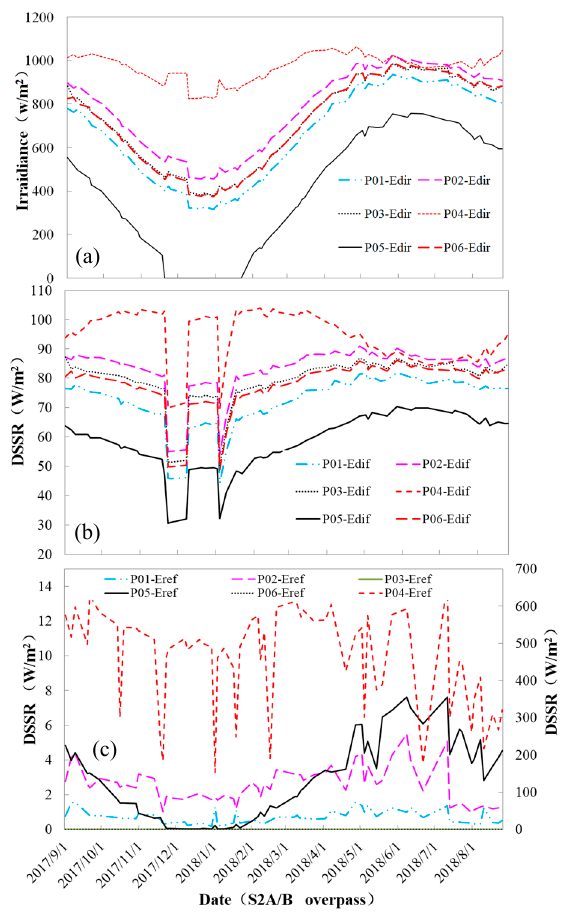
Figure 8. Spatiotemporal variations in the three DSSR components during a mass-balance year at 6 points during the S2A/B overpass time: ( a ) direct radiation; ( b ) diffuse radiation; and ( c ) surrounding-reflected radiation.